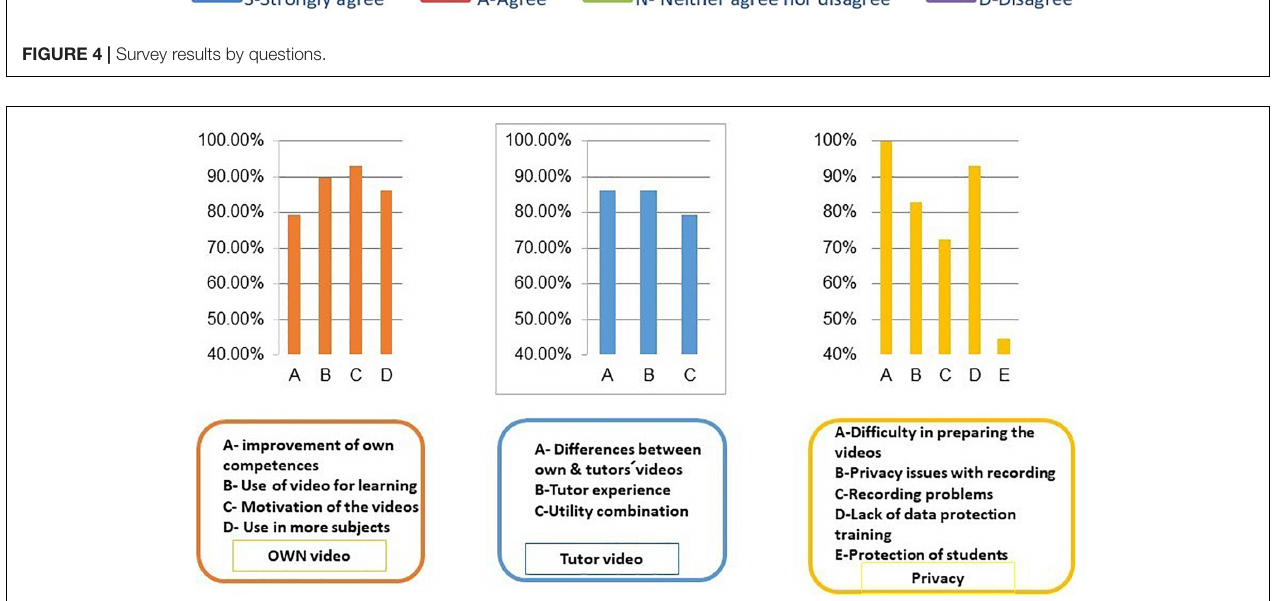
FIGURE 5 | Survey results by main